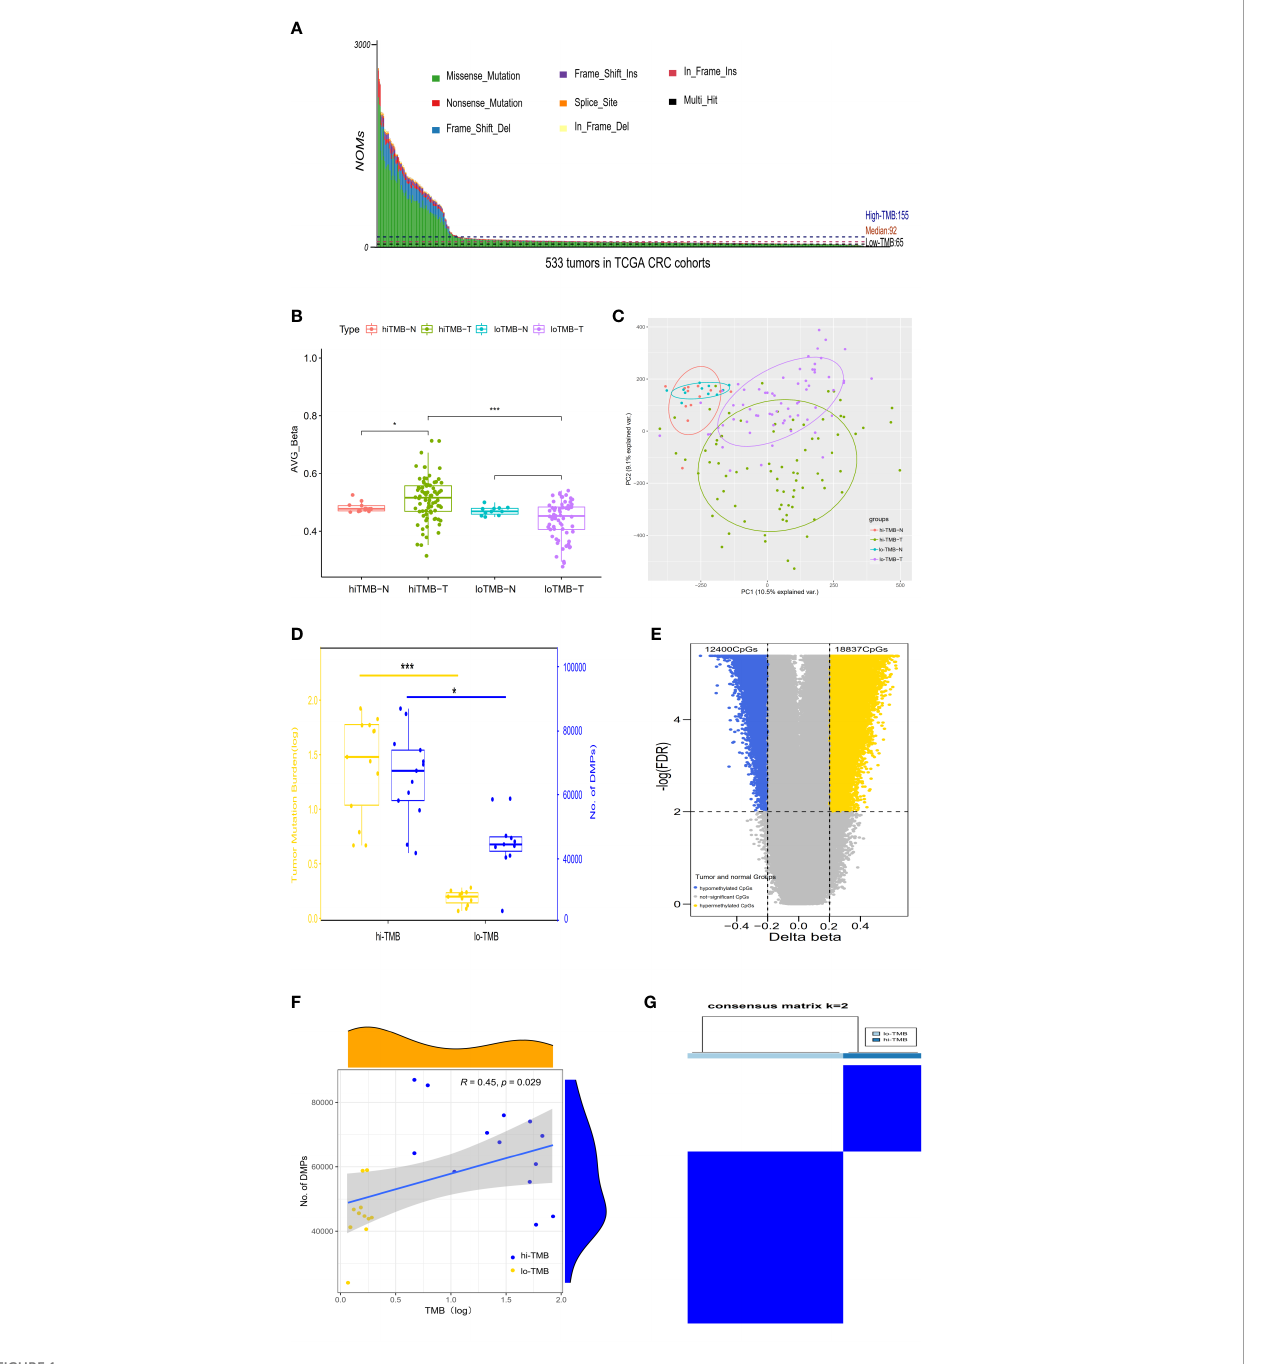
FIGURE 1 The correlation between differential DNA methylation and TMB in colorectal cancer. (A) The number of non-synonymous coding somatic mutations (NOMs) for every CRC patient (represented by the x-axis). Blue/Black lines represent the high/low TMB cutoff value. The samples of above 3000 NOMs were not shown in the fi gure. (B) Bar plot. (C) PCA analysis for the average value of all 450K methylation CpG sites in high/low TMB. (D) The comparison of differences in DNA methylation between high TMB and low TMB groups; with yellow representing the value of log (TMB) and blue indicating the positions of differential methylation. (E) The Volcano plot between delta-beta value (high TMB tumor versus normal) and corresponding – log (FDR) for all 450K methylation CpG sites, with the blue indicating hypermethylated CpGs and the yellow representing hypomethylated CpGs. (F) The correlation analysis of differential methylation sites and TMB of CRC patients. (G) Consensus clustering of the DNA methylation distinguishing high and low TMB CRC groups of DNA methylation, the rows and columns represent DMPs and samples in the consistent clustering matrix heatmap, respectively. (* P < 0.05; *** P <